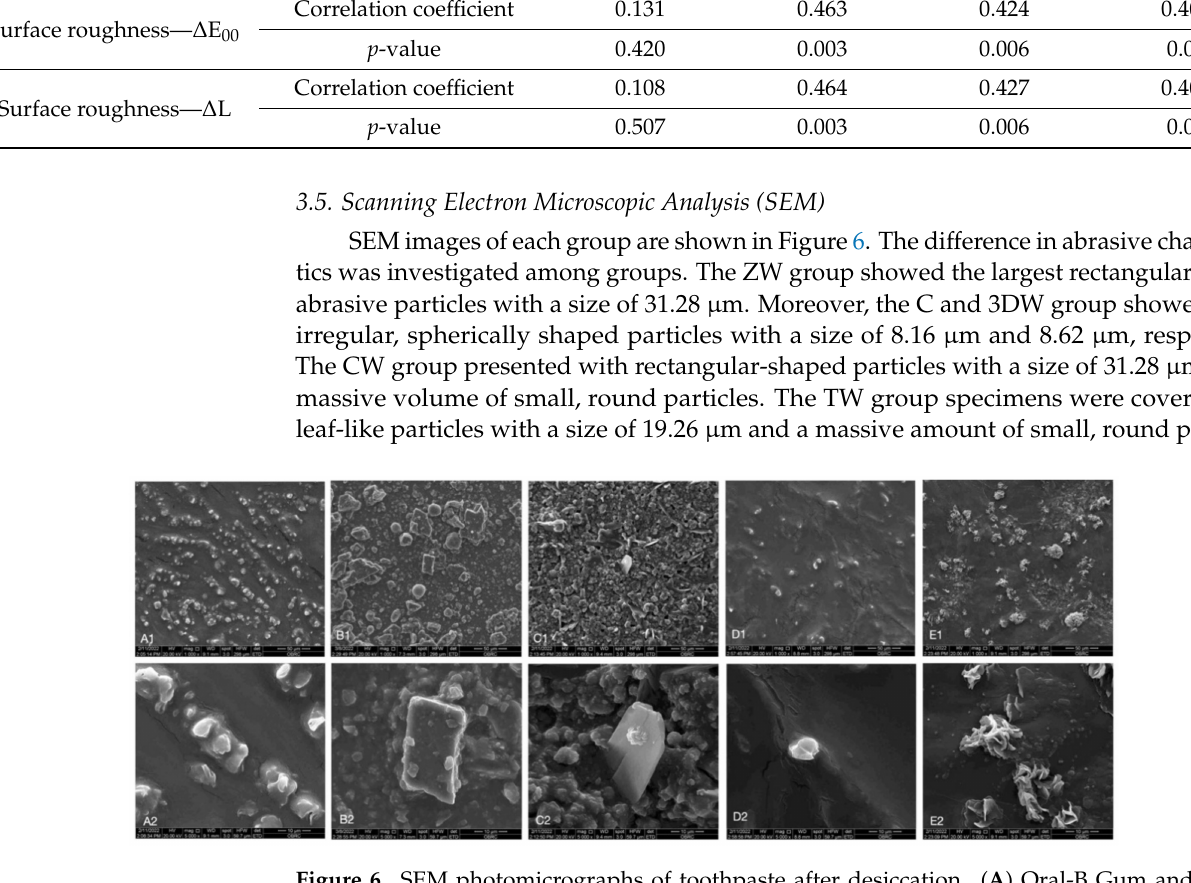
Figure 6. SEM photomicrographs of toothpaste after desiccation. ( A ) Oral-B Gum and